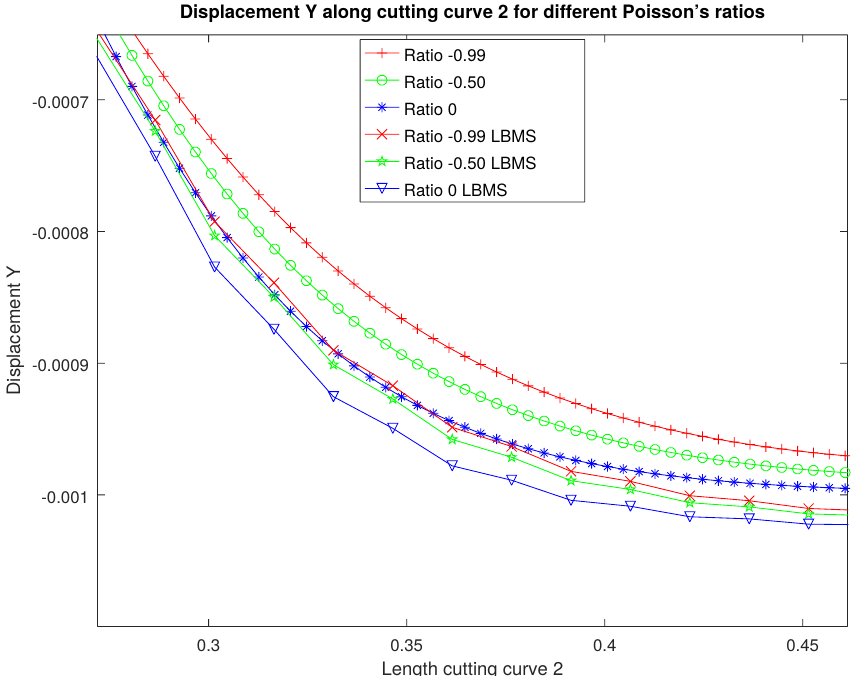
Figure A13. Detailed view of second displacement components along cutting curve C 2 for negative Poisson’s ratios.